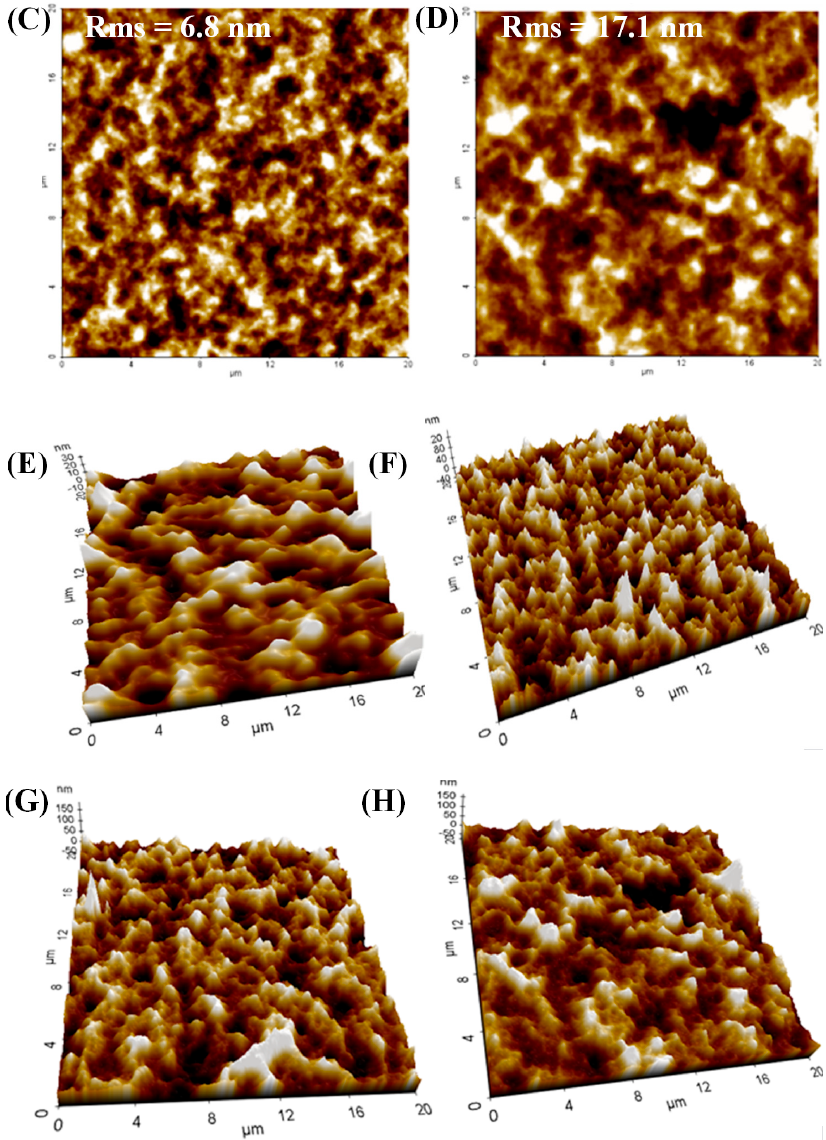
Figure 3. ( A , B ) AFM images of the P3HT:IC 60 BA and P3HT:IC 60 BA:DHP films without thermal annealing, ( C , D ) AFM images of the P3HT:IC 60 BA and P3HT:IC 60 BA:DPH films annealed at 150 °C for 10 min, ( E , F ) 3D AFM images of the P3HT:IC 60 BA and P3HT:IC 60 BA:DHP films without thermal annealing, and ( G , H ) 3D AFM images of P3HT:IC 60 BA and P3HT:IC 60 BA:DPH films annealed at 150 °C for 10 min.